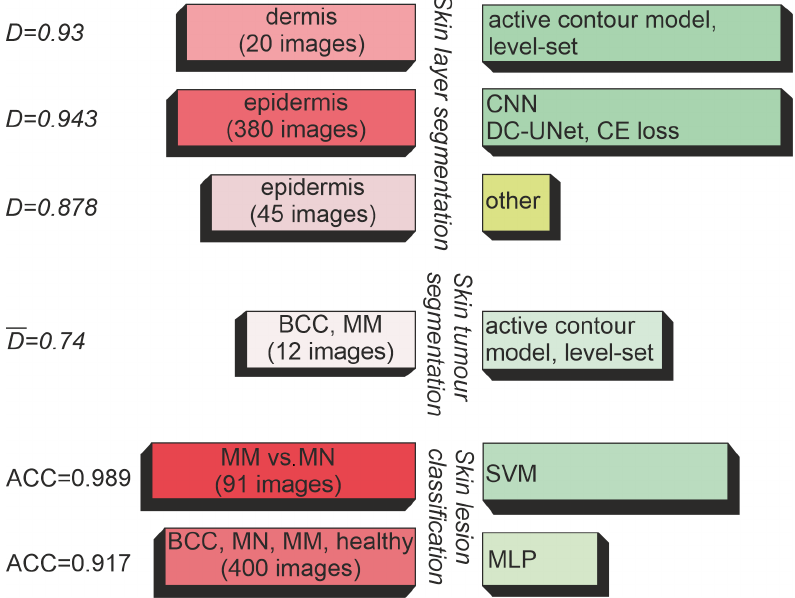
Figure 5. Summary of the most developed areas of CAD of skin diseases in